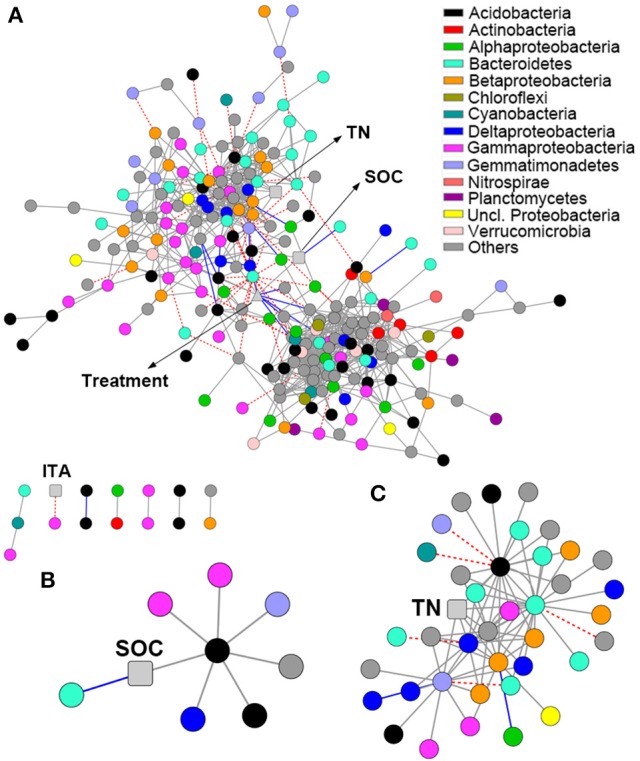
Network analysis revealing the associations among bacterial OTUs and soil properties. Gray solid line, blue solid line and red dash line represent strong positive linear (r > 0.8), strong negative linear (r < −0.8) and strong nonlinear (MIC-ρ2 > 0.8) relationships, respectively. Colored nodes signify corresponding OTUs assigned to major phyla and classes. Soil properties are indicated with round rectangle, and treatment with triangle. SOC, soil organic C; TN, total N; ITA, invertase activity. (A) Network co-occurrences of OTUs substantially enriched by long-term fertilization; (B,C), Subnetworks for the associations of SOC (B) and TN (C).